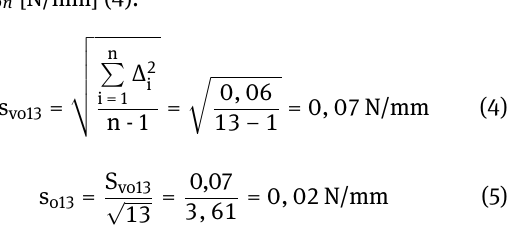
tion, s von [N/mm]